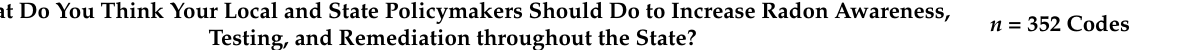
Table 8. Main themes for what policymakers should do to increase radon awareness, testing, and remediation among radon testing survey participants, Utah County, Utah, May 2014–January 2016. What Do You Think Your Local and State Policymakers Should Do to Increase Radon Awareness, Testing, and Remediation throughout the